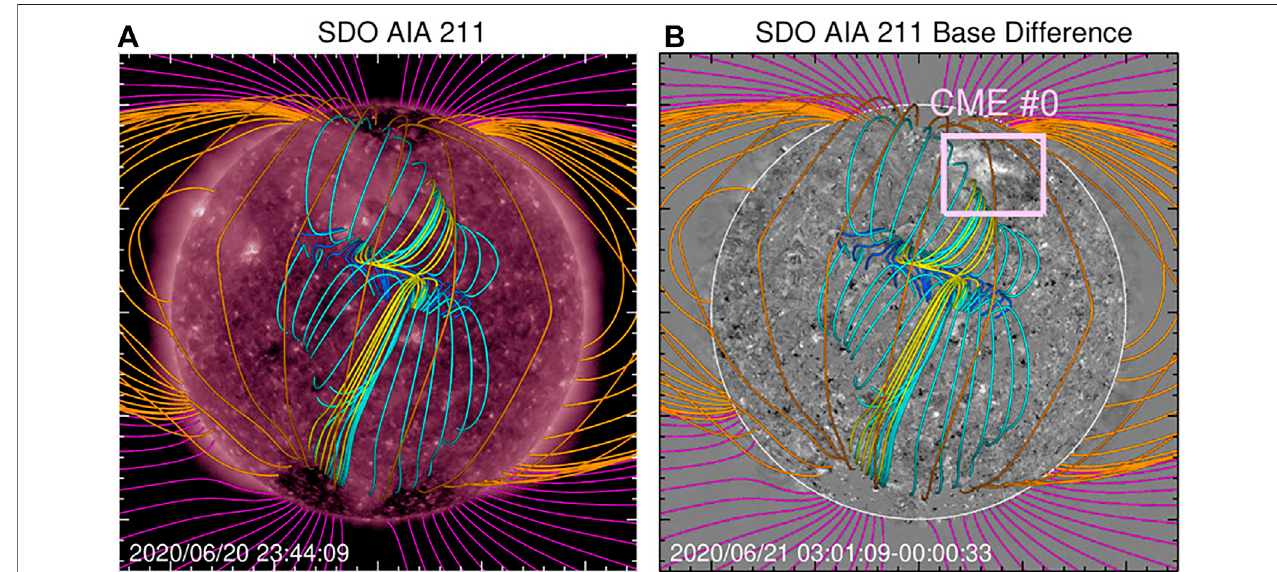
FIGURE 2 | (A) SDO/AIA 211Å emission and representative PFSS magnetic fi eld lines illustrating the different fl ux systems on the Earth-facing solar disk. (B) The same PFSS fi eld lines plotted over the base-difference 211Å image. The on-disk eruption signatures (and source region) for CME #0 (pink) are to the northwest of the multipolar fl ux system.